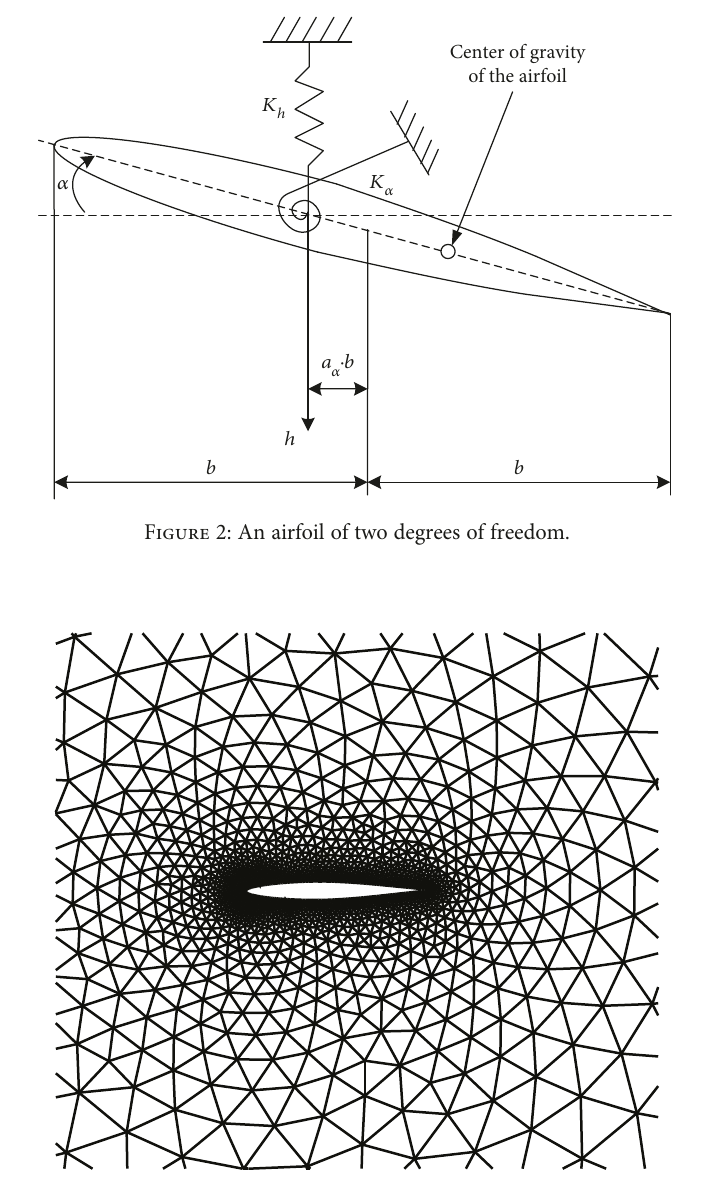
Figure 3: The CFD grid for the NACA64A010